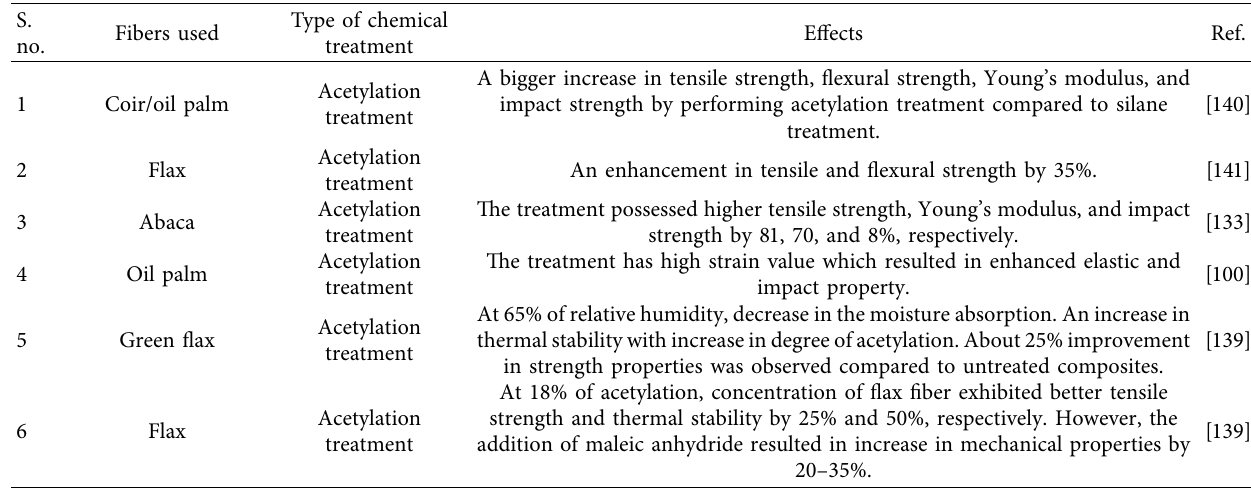
Table 3: Effect of acetylation treatment on various